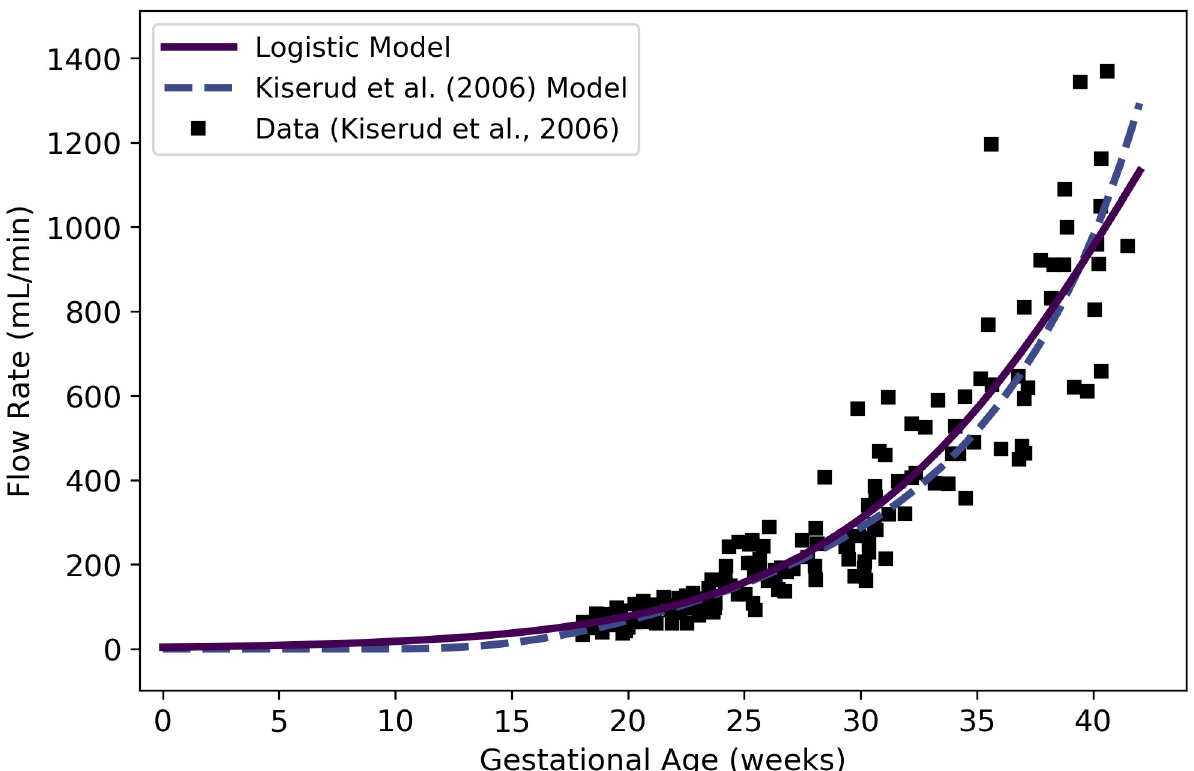
Fig 22. Fetal blood flow through the right ventricle vs. gestational age. The logistic model (solid line) given by Eq 44 was selected as the most parsimonious model in our analysis. The model of Kiserud et al. [38] was calibrated using the same data set [38] used by us.